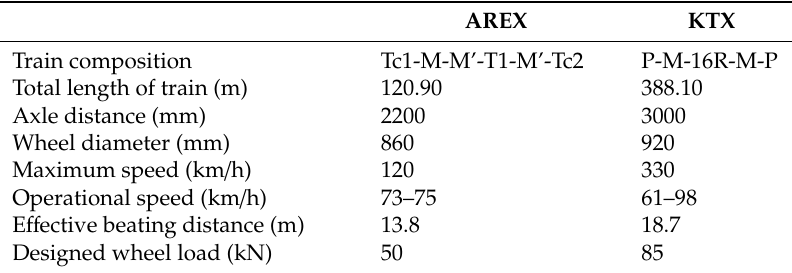
Table 1. Properties of the tested